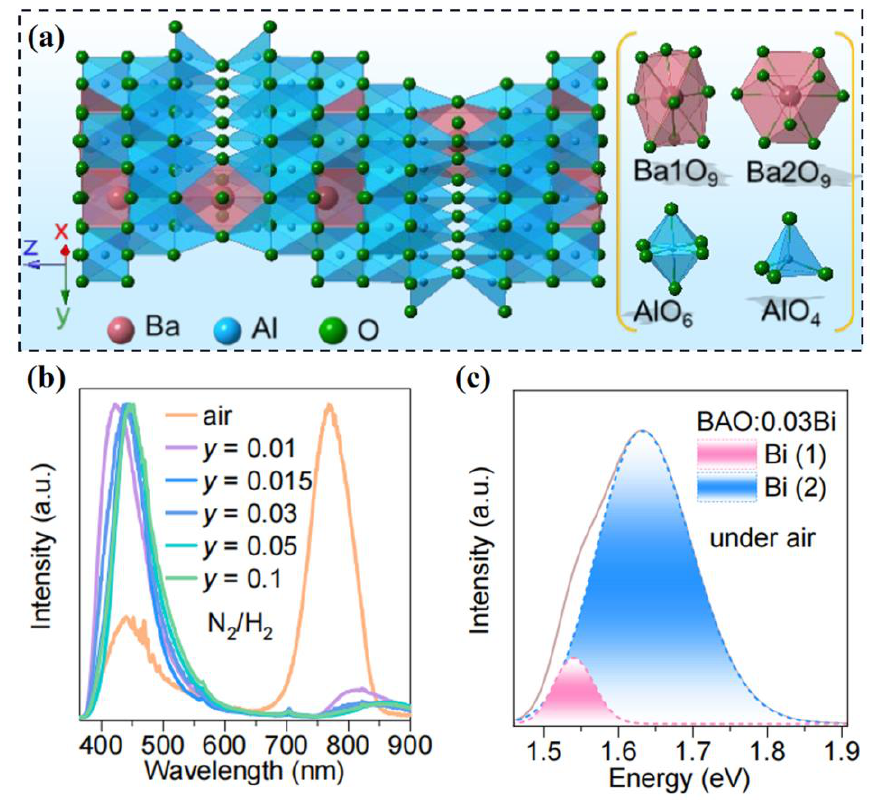
Figure 9. ( a ) Schematic crystal structure diagram of BaAl 12 O 19 matrix. ( b ) PL spectra of BaAl 12 O 19 :Bi 3+ -air and BaAl 12 O 19 :yBi 3+ -N 2 -H 2 (0 ≤ y ≤ 0.10). ( c ) Gaussian fitting PL spectra of BaAl 12 O 19 :Bi 3+ -air ( λ ex = 330 nm). Reprinted with permission from ref. [87]. Copyright 2020 American Chemical Society.